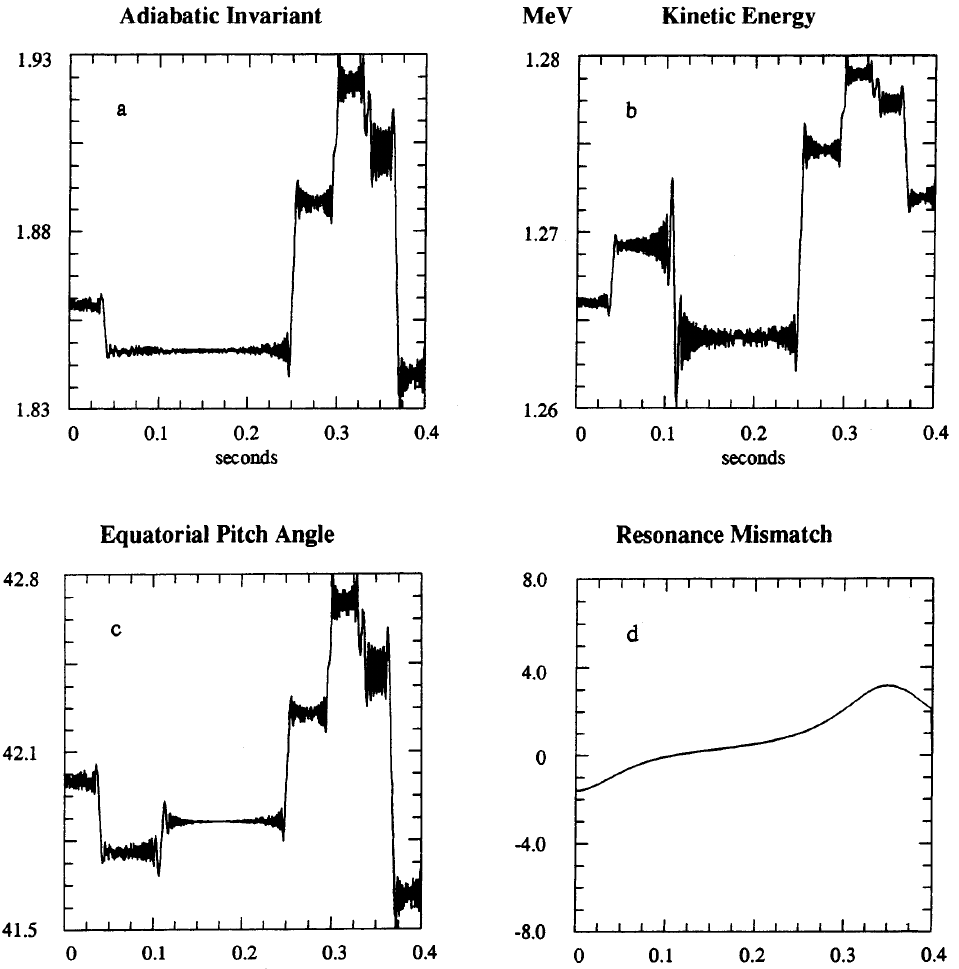
Fig. 1. (a) Adiabatic invariant, (b) kinetic energy, (c) equatorial pitch angle and (d) resonance mismatch as a function of time, for a bouncing energetic